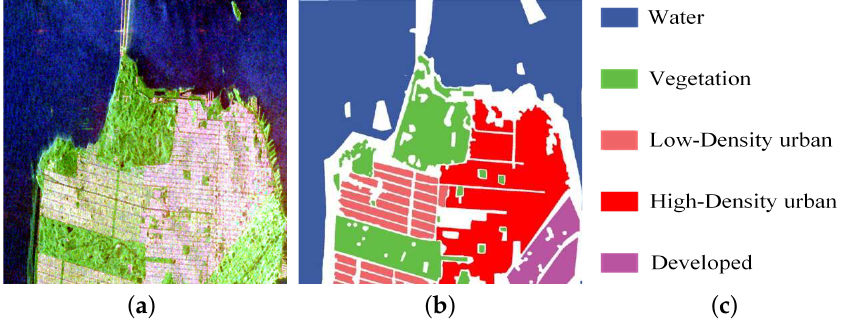
Figure 8. San Francisco datasets of 5 class. ( a ) Pauli RGB. ( b ) Corresponding Ground-truth. ( c )